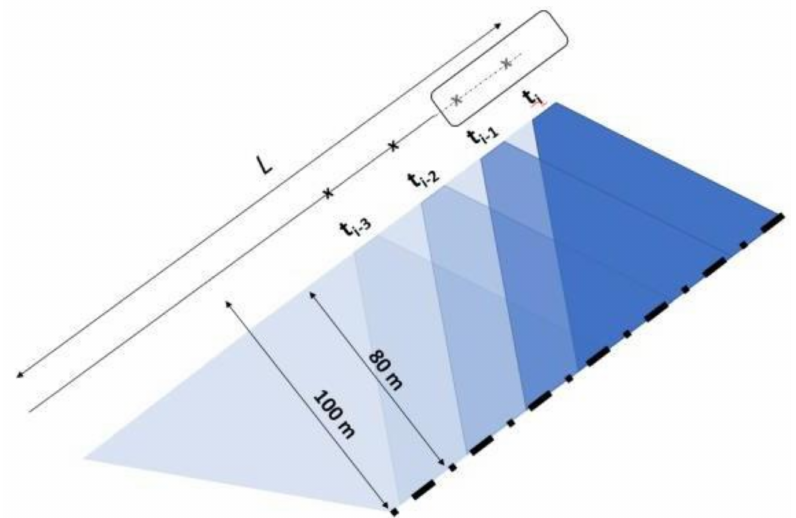
Figure 3. Illustration of a one-sided photo transect, showing the length L, the different timestamps tx, and the cut-off perpendicular distance (heavy dashed line) inferred from the data. At a 2 s interval and 10 knots speed, the photographed areas will